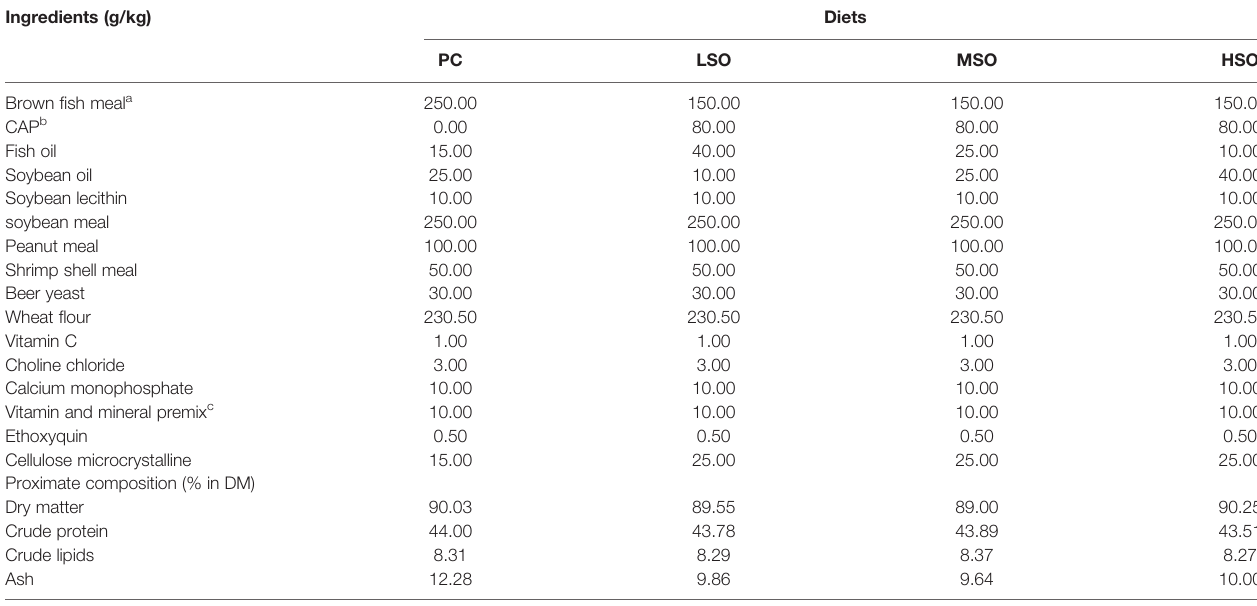
TABLE 1 | Formulation and proximate composition of diets used in this study (dry matter basis). Ingredients